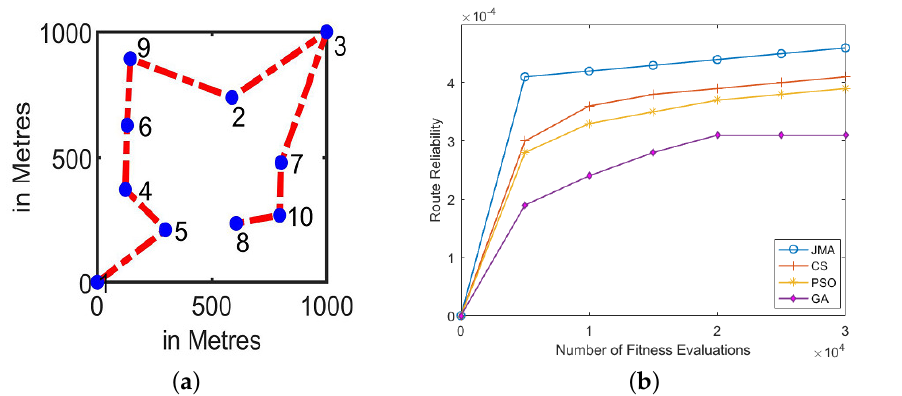
Figure 6. Low Vehicular Density (10 vehicles). ( a ) Best route discovery achieved using JMA; ( b ) Mean route reliability results achieved across 1000 Monte Carlo